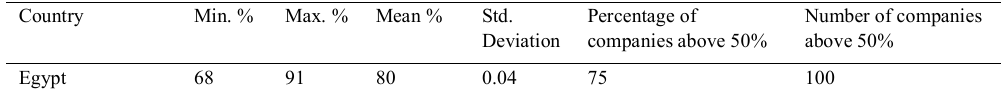
Table 1: Descriptive Statistics of the Extent of Compliance with Mandatory IFRSs by Companies Listed on the EGX. Country Min.